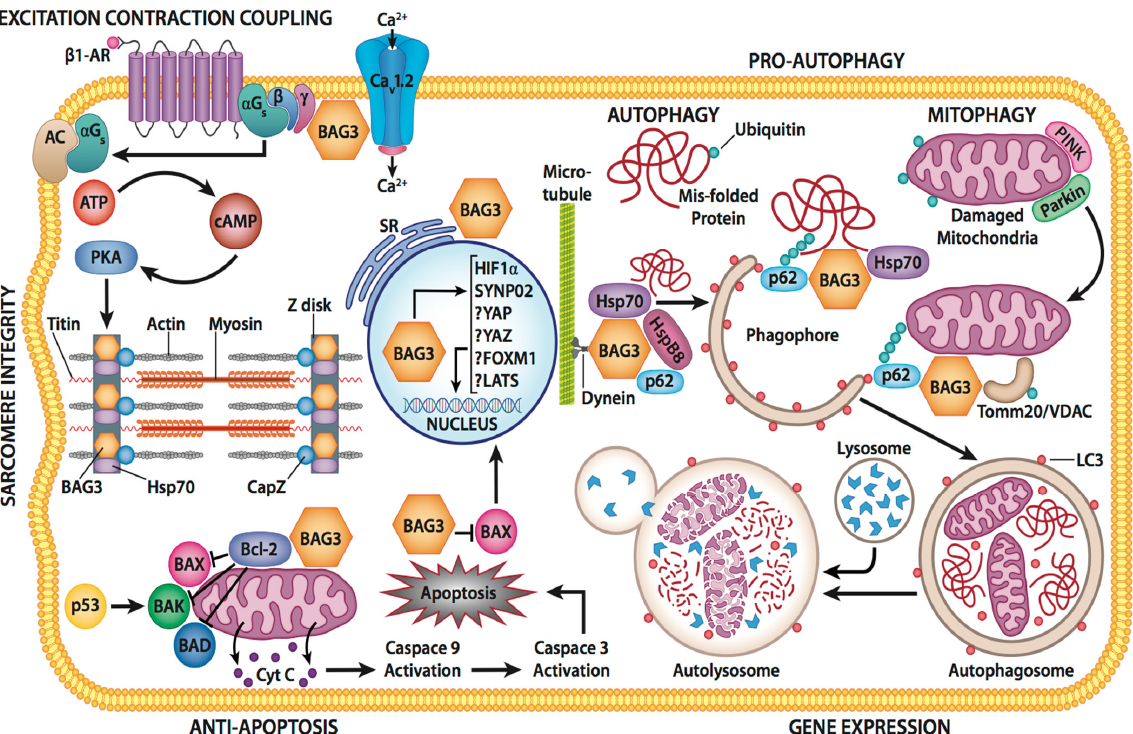
Figure 2. Diverse cellular roles of BAG3. The major pathways that require BAG3 for optimal functioning including excitation-contraction coupling, sarcomere integrity, Ca 2+ homeostasis, au- tophagy, apoptosis, and gene expression. α G s —alpha subunit of the guanine nucleotide binding protein; β 1-AR—beta1-adrrenergic receptor; AC—adenylyl cyclase; ATP—adenosine triphosphate; BAD—B-cell lymphoma-2-associated death; Bax—B-cell lymphoma-2-associated x protein; BAK— B-cell lymphoma-2 homologous promoter; antagonist/killer; Bcl-2—B-cell lymphoma-2; cAMP— cyclic adenosine monophosphate; Ca v -1.2 = L-type Ca 2+ channel; Cyt C.—cytochrome C; FOX M1— forkhead box 14 M1 transcription factor; HF 1a—hypoxia-inducible factor 1 active transcription